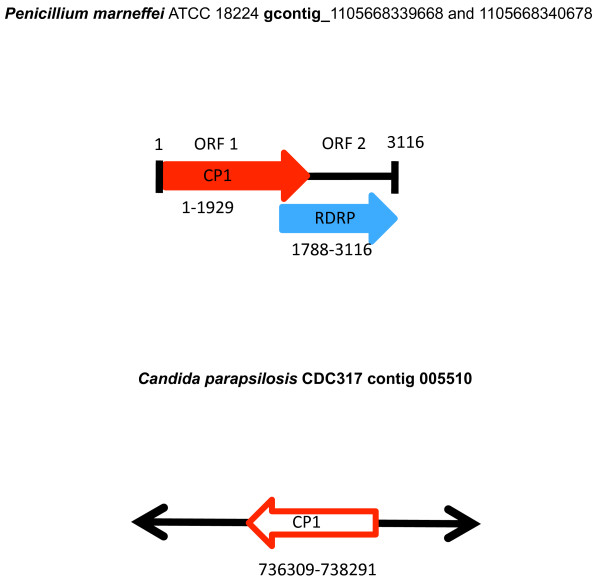
A comparison of the fungal genome maps of Penicillium and Candida proposed to contain endogenous Totivirus-like genes. Red arrows indicate capsid polypeptide-like genes and the blue arrows represent RNA-dependent RNA polymerase-like genes. These coloured arrows represent open reading frames. Black lines represent fungal chromosomal DNA. Gene copies that retain an exogenous viral genomic architecture are shown as solid coloured arrows with the coding strand indicated by the direction of the arrow. Numbers below the gene annotations indicate the contig positions of gene boundaries.